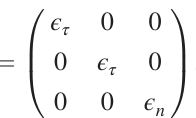
In 0 As and n þ -doped . 48 . 52 ¼ 5 μ m). Red and p (cid:2) n